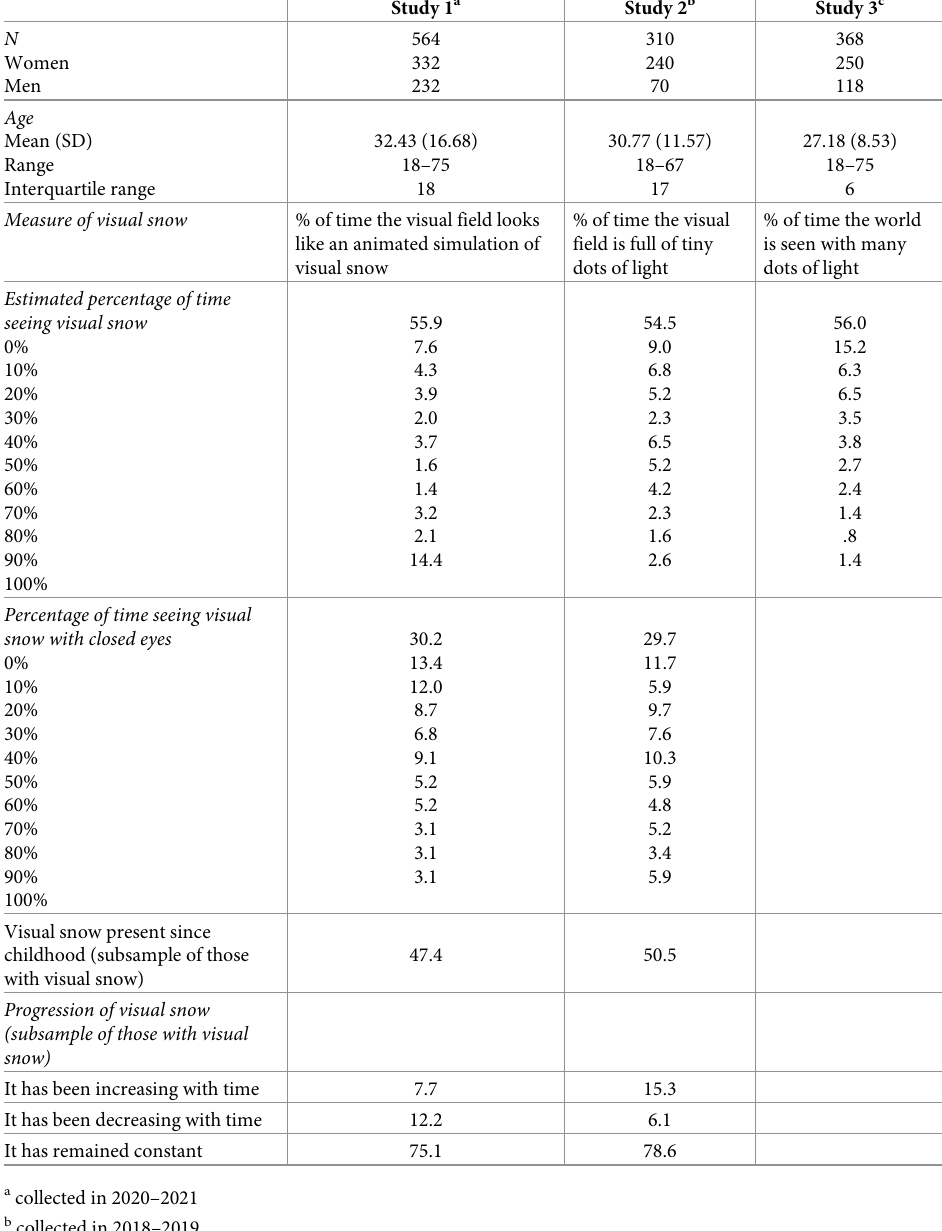
Table 2. Sample characteristics and frequency of visual